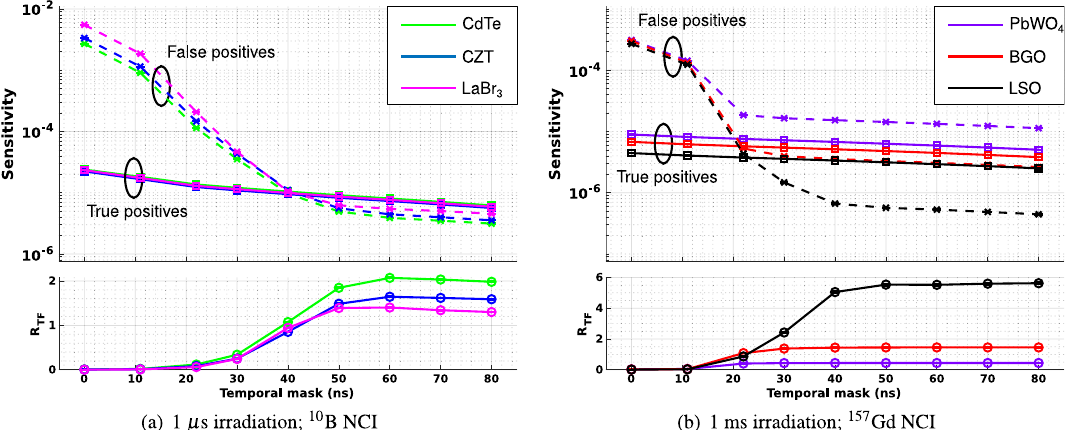
Figure 7. Sensitivity (upper plot) and R TF (lower plot) of events detected using different detector materials 10 following irradiation by a carbon ion beam. For the B NCI, magenta denotes the LaBr 3 detector, green the 157 CdTe detector and blue the CZT detector. For Gd NCI, red denotes the BGO detector, black the LSO detector and purple the PbWO 4 detector. In the upper plots in each subfigure, square markers ( (cid:31) ) joined by unbroken lines denote true positives, while cross markers ( × ) joined by dashed lines denote false positives.